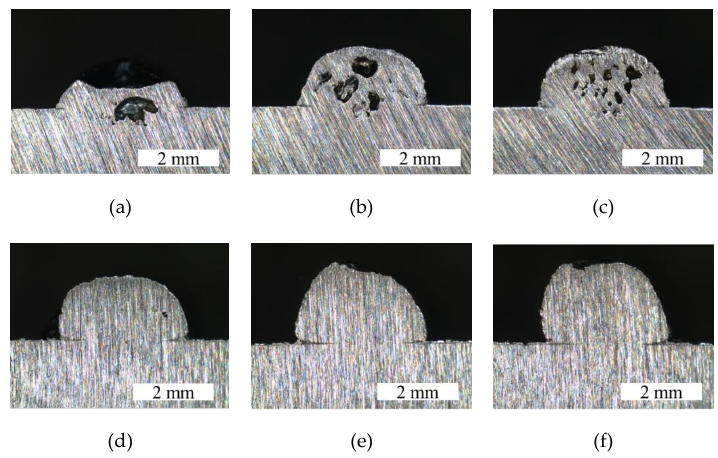
Figure 3. Cross section of bead with various contact tip to work-piece distance ( a ) 5 mm, ( b ) 7 mm, ( c ) 9 mm, ( d ) 11 mm, ( e ) 13 mm, and ( f ) 15 mm.